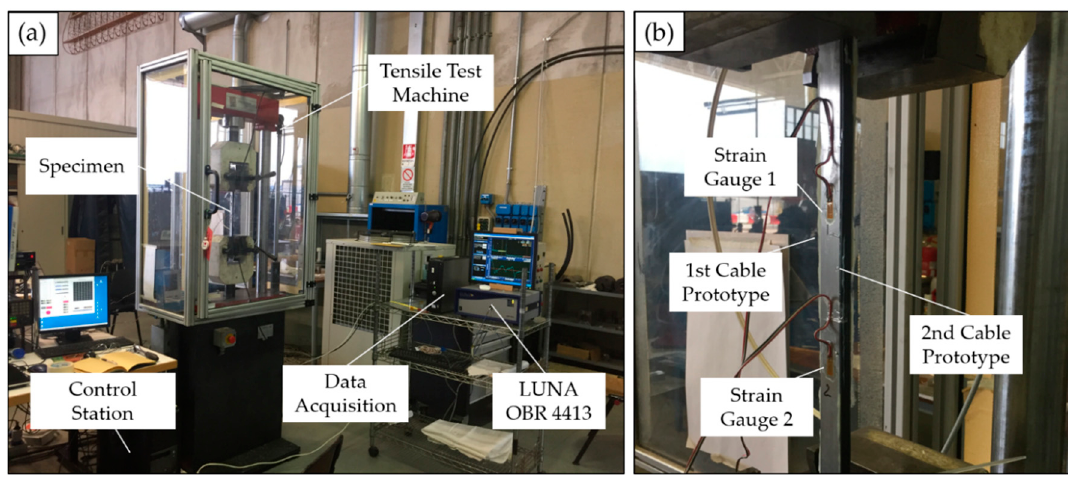
Figure 6. Experimental setup ( a ), and clamped specimen ( b ).